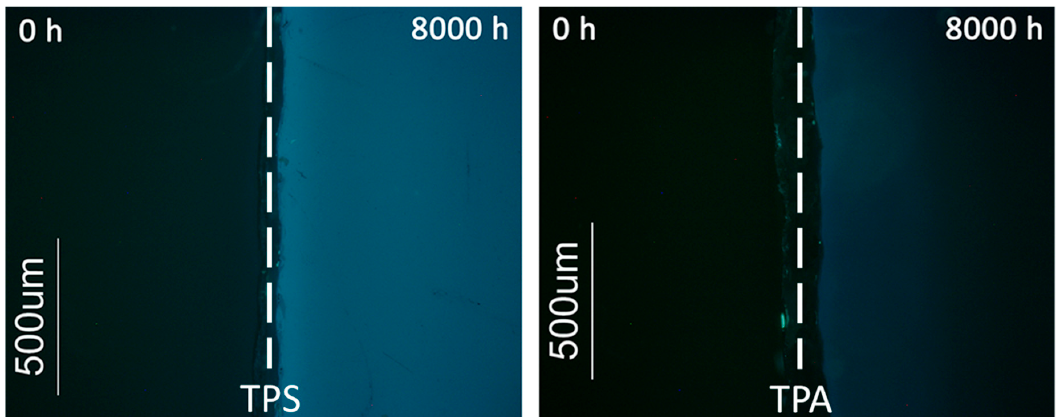
Figure 10. Fluorescence microscopy images under blue-violet light of TPS and TPA surfaces. A non-aged sample (0 h) and an artificial aged sample (8000 h) of each PMMA typology were photographed side-by-side. Both PMMA sheets presented no fluorescence before artificial aging (dark surfaces at 0 h); TPS developed more fluorescence (lighter blue under radiation) than TPA during aging.